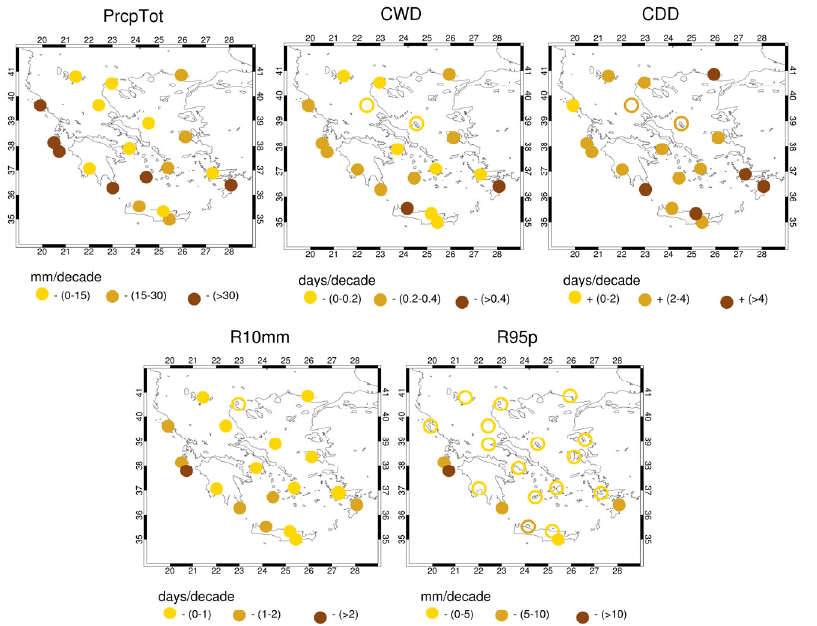
Figure 13. Spatial distribution of trends in extreme climate indices during 1971–2100 over Greece based on RCP8.5. The brown (yellow) circles indicate higher (lower) trends. Filled circles represent statistically significant trends.